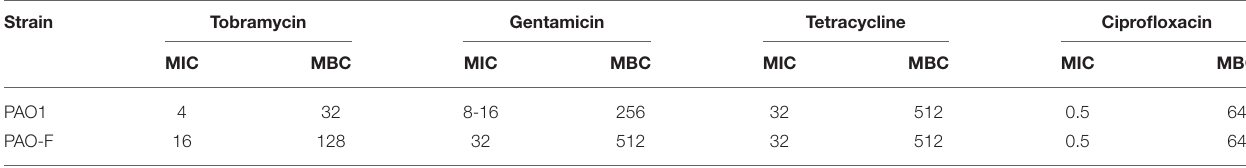
TABLE 2 | MICs and MBCs for the P. aeruginosa PAO1 and PAO-F α . Strain